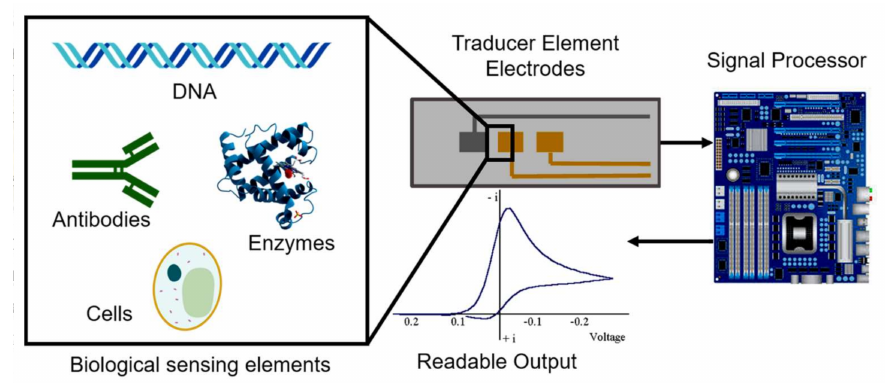
Figure 1. Scheme of an electrochemical biosensor. Biological sensing elements are coupled to electrodes. These traduce the signal to deliver a readable